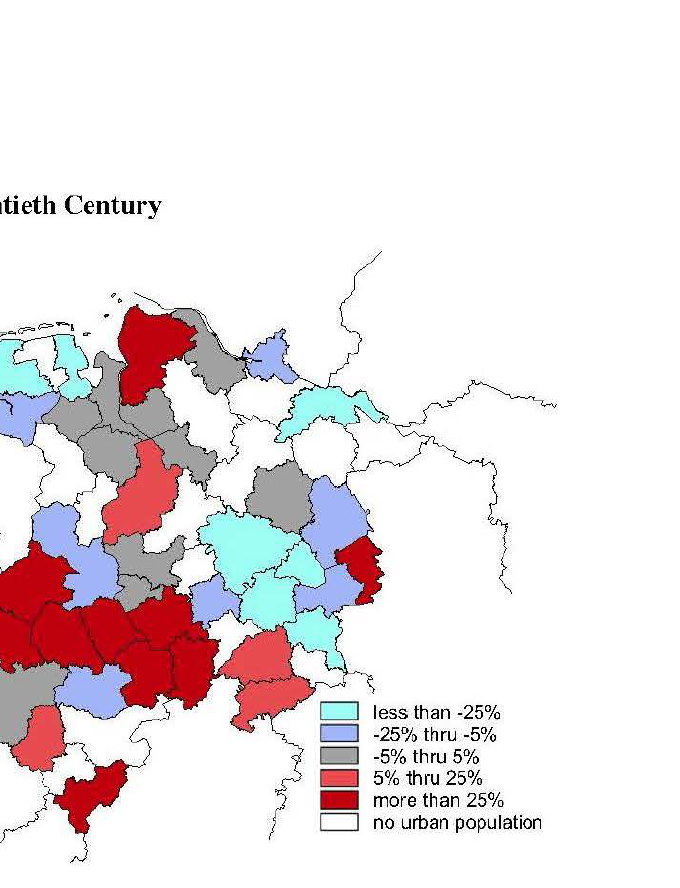
Figure 6. Regional Development in the Twentieth